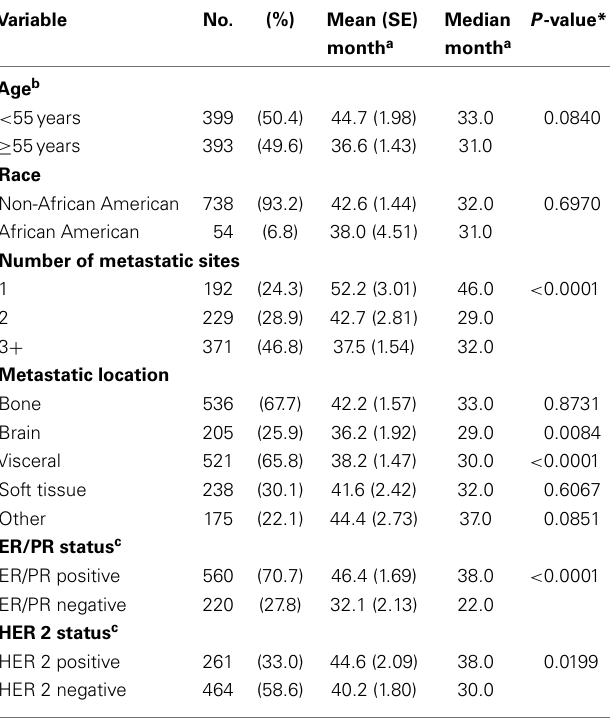
Table 1 | Survival difference according to demographic and tumor